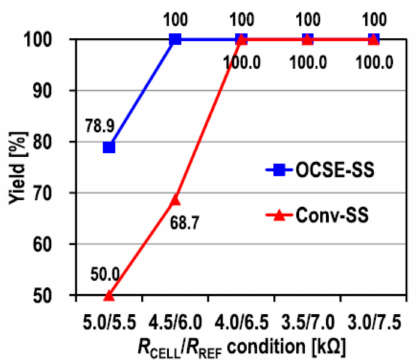
Figure 16. Measured yield versus RCELL/RREF of the Conv-SS and the OCSE-SS at VDD = 0.9 V, VG_clamp = 0.8 V, and t SEN = 20 ns